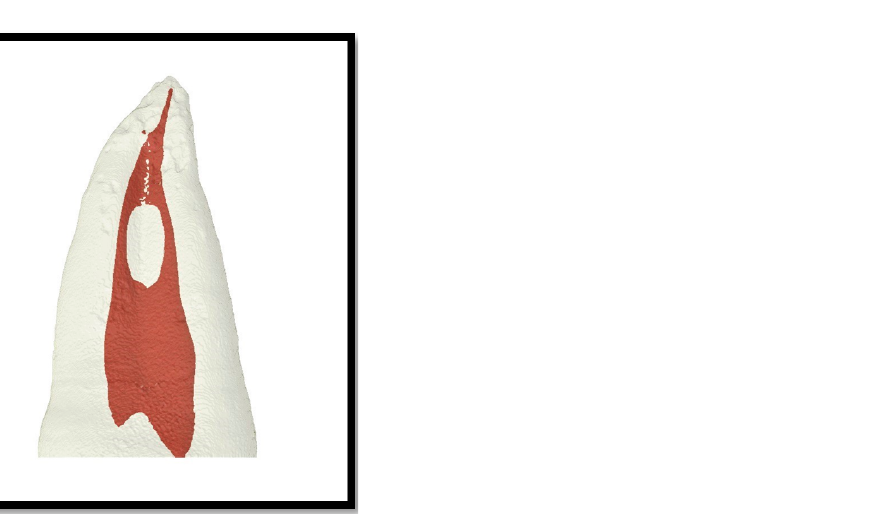
Figure 2. Micro-CT image showing Vertucci’s type II (2-1) canal configuration.